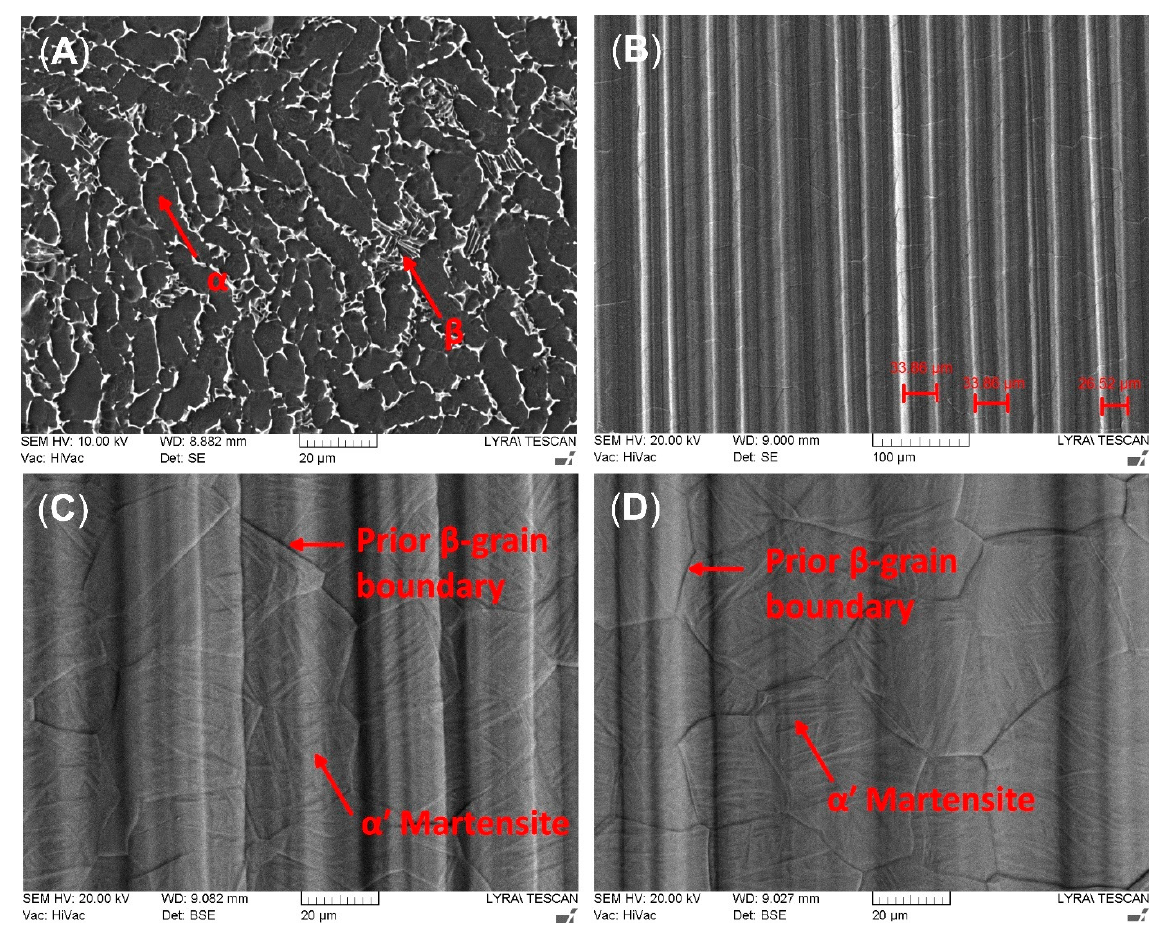
Figure 1. Representative SEM micrographs of ( A ) the initial structure of Ti6Al4V alloy, ( B ) EBM surface of AR500 substrate; ( C , D ) top surface microstructure of EBM AR500 and AR850, respectively, seen at higher magnification. Int. J. Mol. Sci. 2021 , 22 , x FOR PEER REVIEW